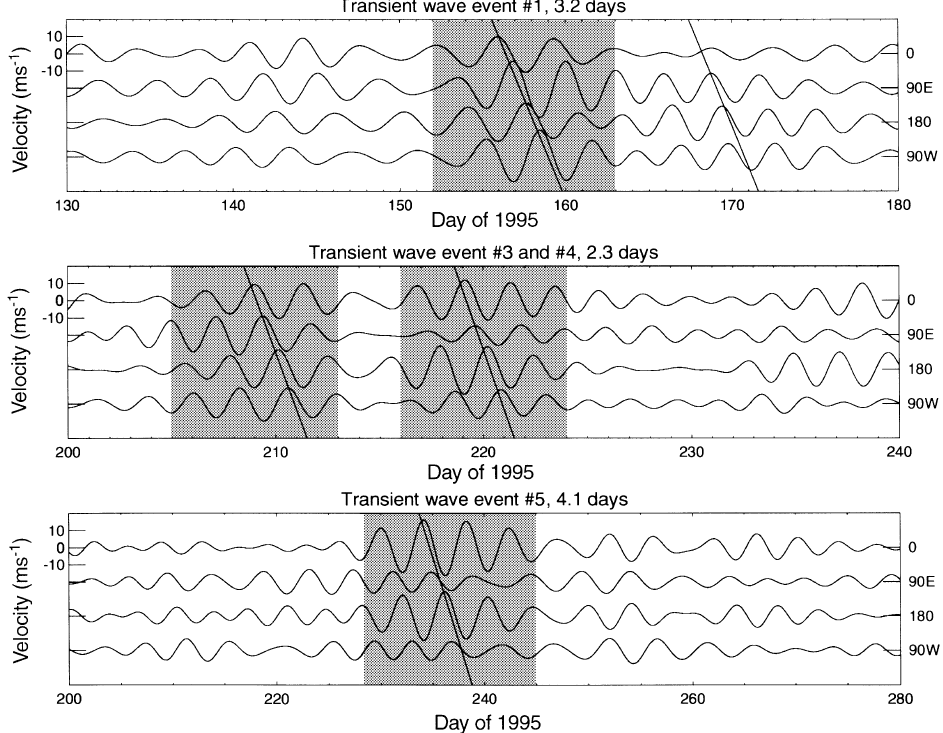
Fig. 10. Filtered time series for wave events 1, 3, 4, and 5. The results for each viewing direction are shown. The shaded region indicates the duration of the